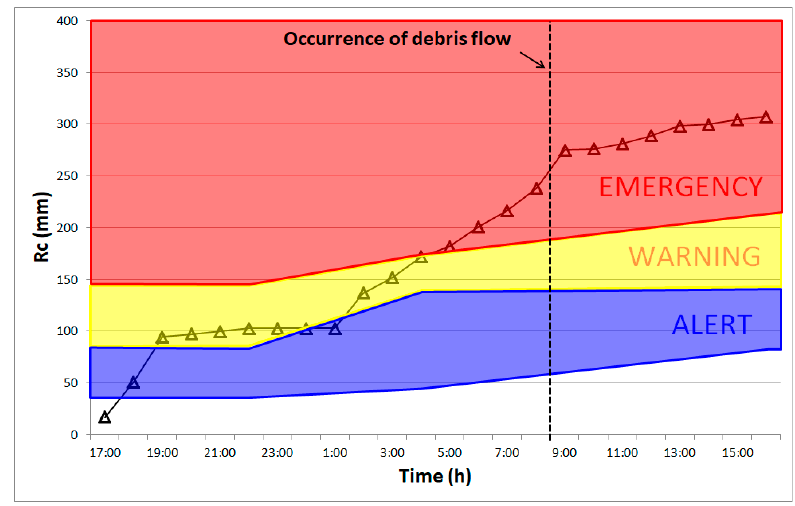
Figure 15. Hyetograph (Case 1).